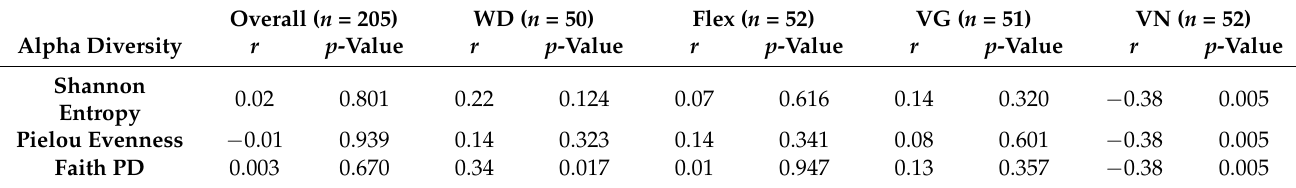
Table 6. Pearson correlation between carbohydrate intake (g/day) and alpha diversity in diet types.